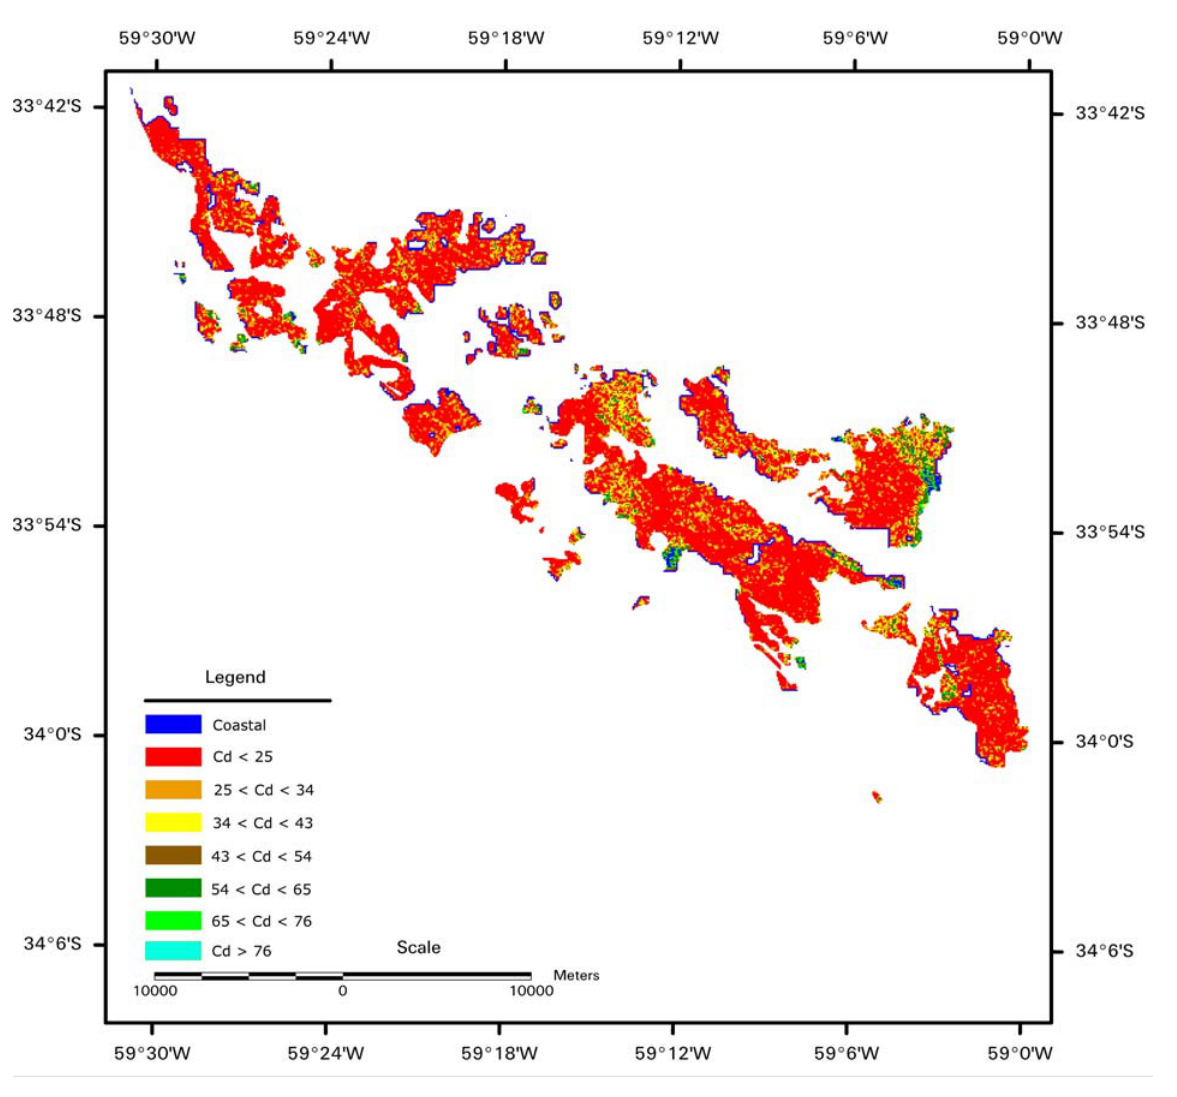
Figure 8. Map of junco marsh drag coefficient derived from the ASAR image of 2008.09.01 using the methodology described in (4.3). Only burned junco marsh area